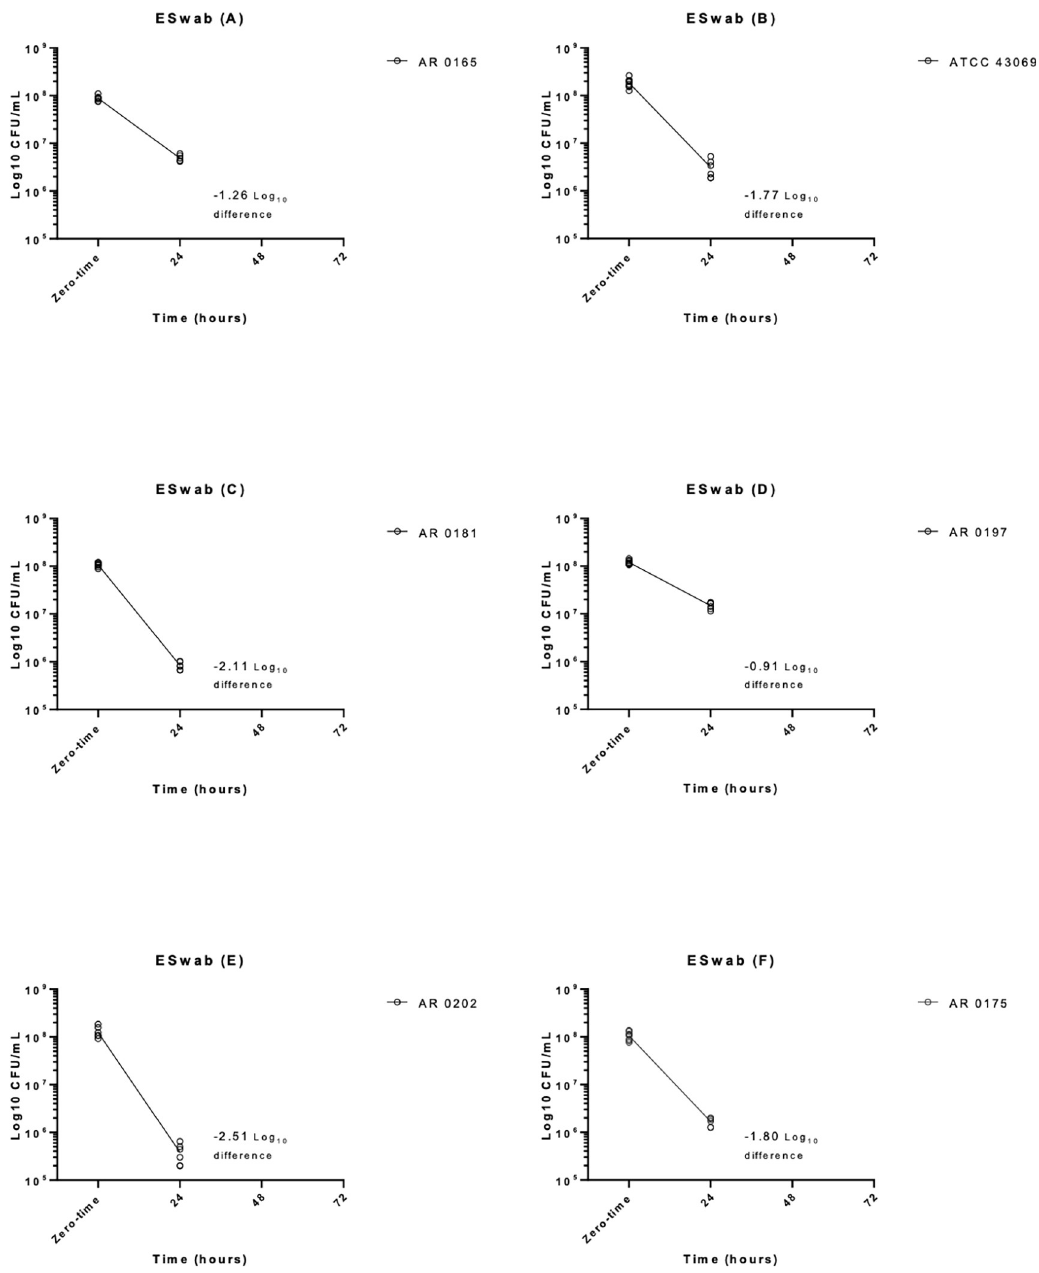
Fig 3. Time in hours versus Log10 CFU/mL for the Copan ESwab for all six strains. CFU; colony forming units. of 19˚ Celsius, and an average of 20.2˚ Celsius (Std: 0.6˚ Celsius) (S2 Fig). Strains AR 0202 and AR 0175 were also stored under ambient conditions, with an average temperature of 23.1˚ Cel- sius (Std 0.2˚ C), a maximum temperature of 24˚ Celsius, and a minimum temperature of 23˚ Celsius (S3 Fig). All inoculum verification tests confirmed strain viability of the experimental groups, including for strain AR 0202, which initially failed for all experimental groups before being repeated.